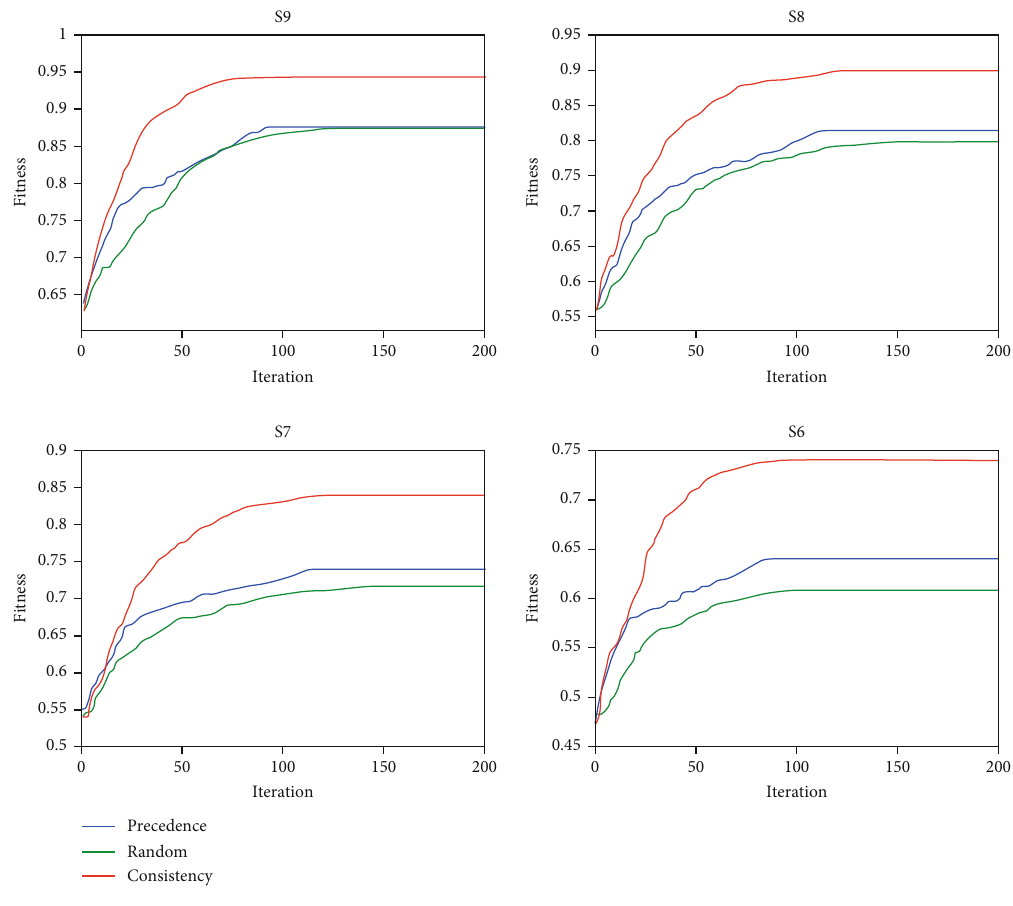
Figure 9: The fi tness curves of di ff erent mutation methods. Table 4: The best values and iterations of di ff erent mutation